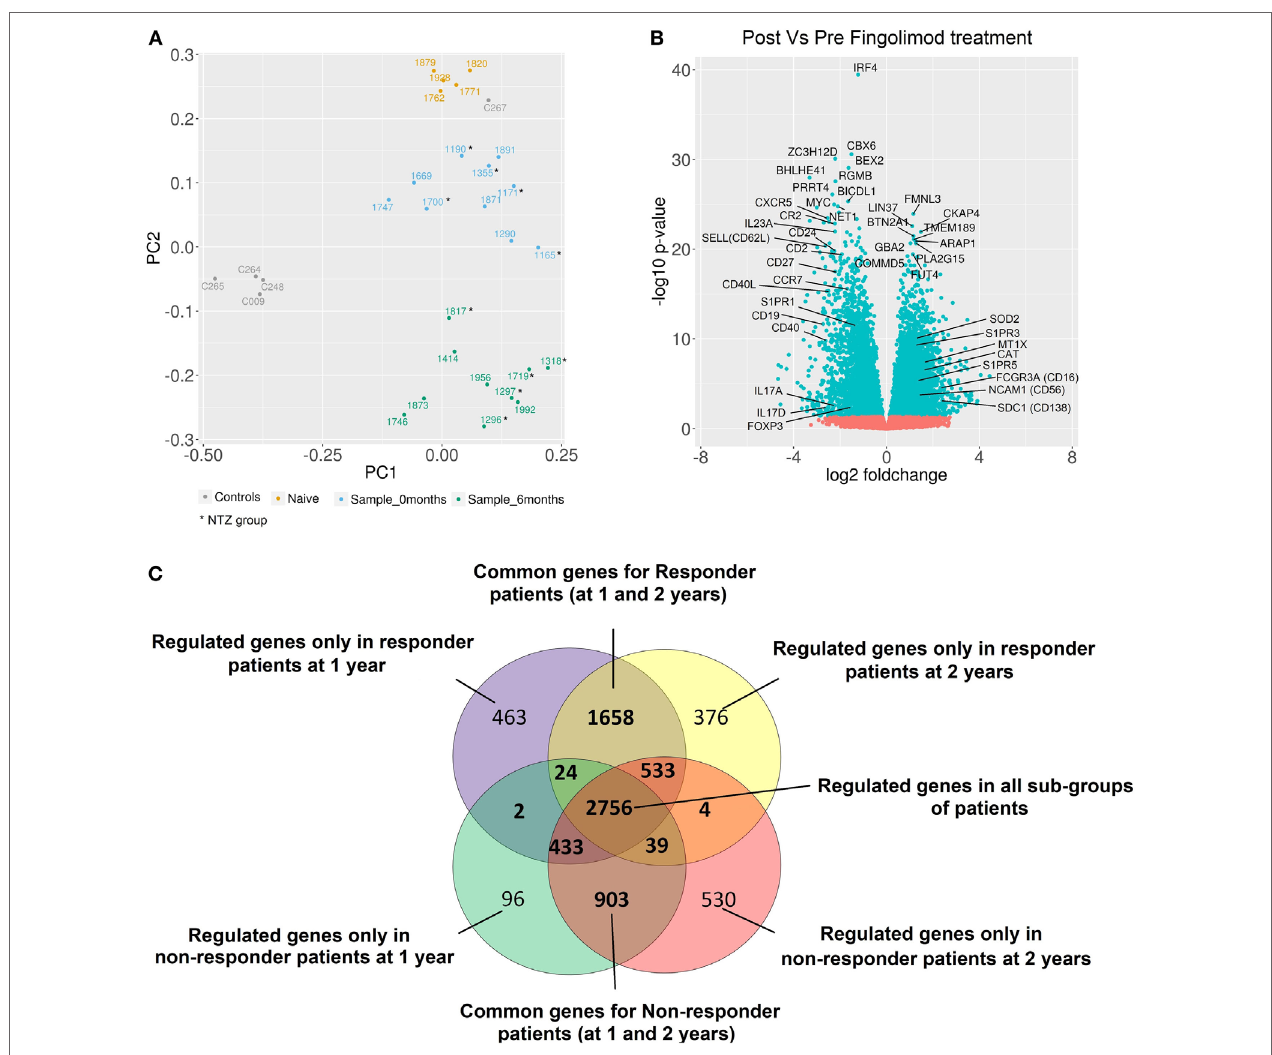
FigUre 4 | Alteration of gene expression profiles by fingolimod in peripheral blood mononuclear cells from multiple sclerosis (MS) patients. (a) The principal component analysis of gene expression profiles of all samples is shown. All healthy controls (gray) were transcriptomically similar except one of them (C267) who exhibited a gene expression profile more similar to naïve patient gene expression. This sample was not considered for further analysis. According to gene expression profiles, the samples from naïve patients (yellow) were located closer to samples from patients before treatment. The samples from patients after treatment (green) were located in a well-differentiated region of space indicating the strong fingolimod effect on gene expression. In samples from patients before (blue) and after treatment (green), no differences between NTZ and no-NTZ groups were found. (B) Volcano plot of differentially expressed genes (DEGs) between samples before and at 6 months of treatment for all samples. The most important genes related to MS and autoimmunity are indicated. (c) The Venn diagram shows the overlap of DEGs between different subgroups: responder and non-responder patients at 1 and 2 years. Responder patients = NEDA-4 patients and non-responder patients = EDA-4 patients (adjusted p -value <